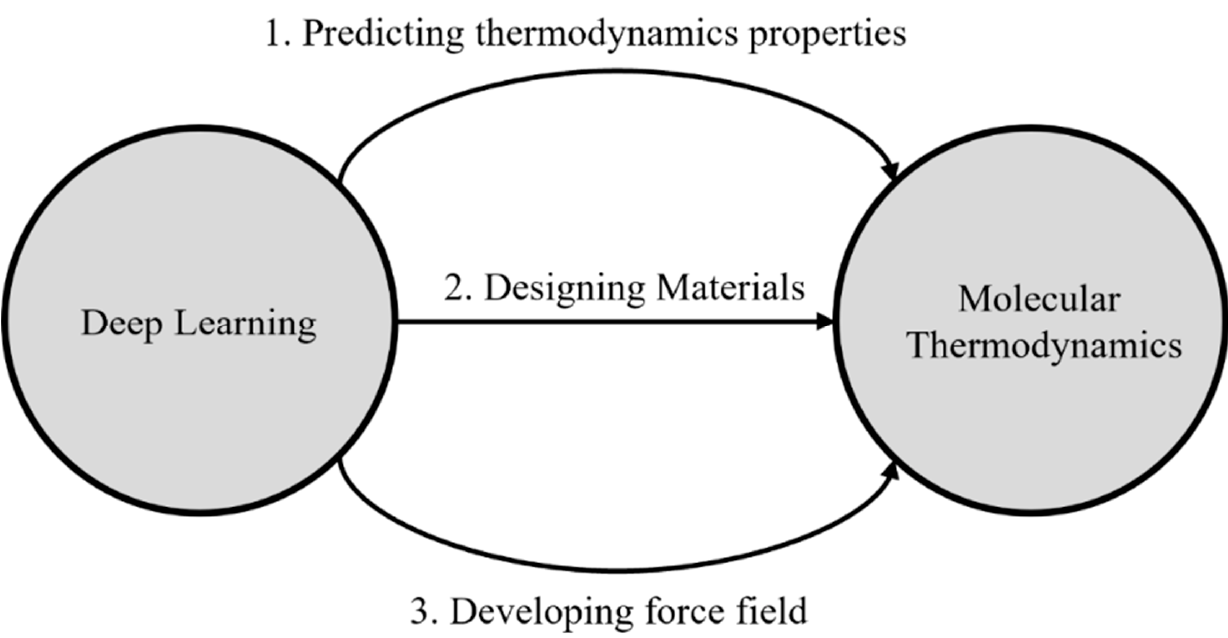
Figure 1. Three aspects of DL in the study of molecular thermodynamics. (1) the development of many-body force fields for the purpose of simulating complex systems; (2) the estimation of thermodynamic parameters using molecular characterization; (3) the construction of materials using large-scale molecular simulations as an integral part of the process.